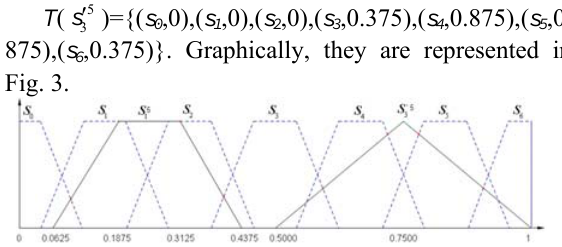
Fig. 3. The results of 5